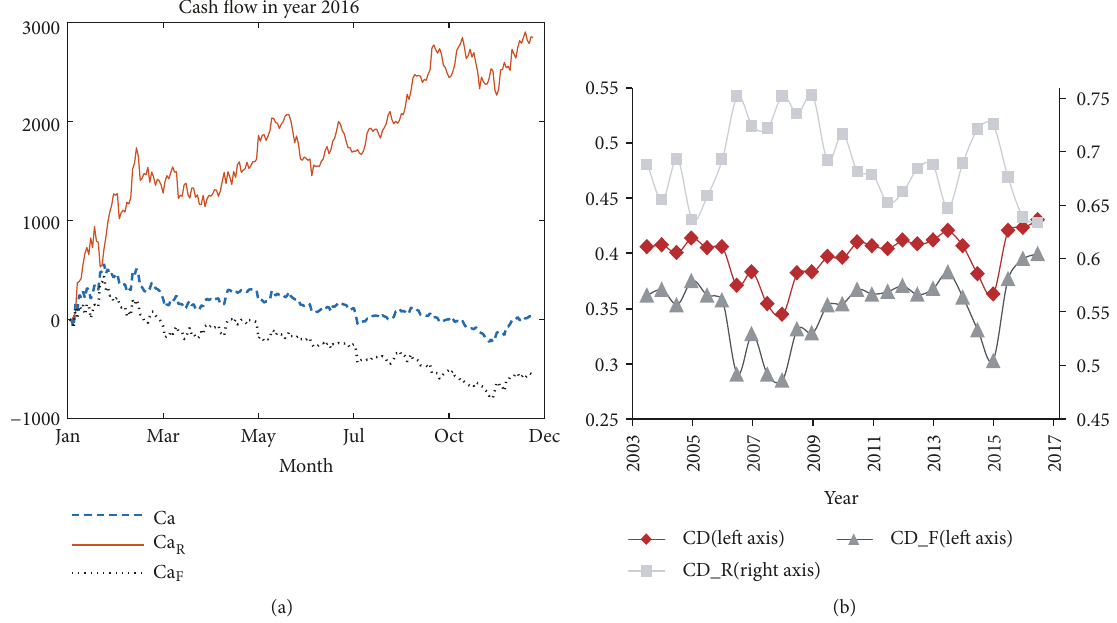
Figure 6: (a) Cash flows of contrarians and followers. Here we set 𝛼 =0.002, 𝑅 𝑚 =132. Data resource: quotes of CSI300 Index from Jan 1 𝑠𝑡 2016 to Dec 31 𝑠𝑡 2016. (b) Comparison of the averagecontrarian degree (CD), the contrarian degree of contrarian timers ( 𝐶𝐷 𝑅 ), and the contrarian degree of followers ( 𝐶𝐷 𝐹